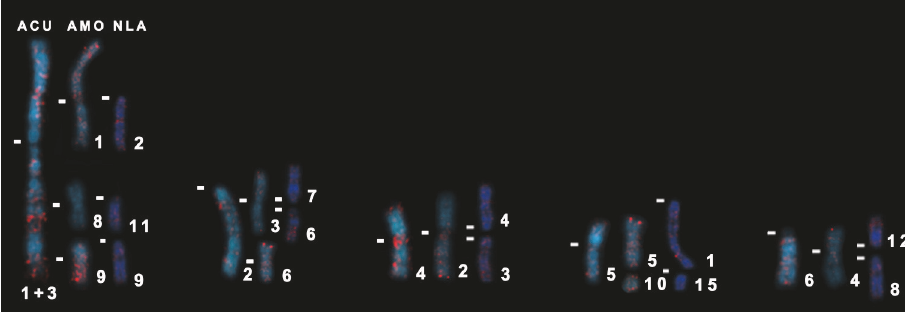
Figure 6: Correspondence between the B1 SINE-hybridized chromosomes of Akodon cursor (ACU), on the left, A. montensis (AMO), in the middle, and Necromys lasiurus (NLA), on the right. Chromosome correspondences were based on Supplementary Figure 1 . (-) centromere